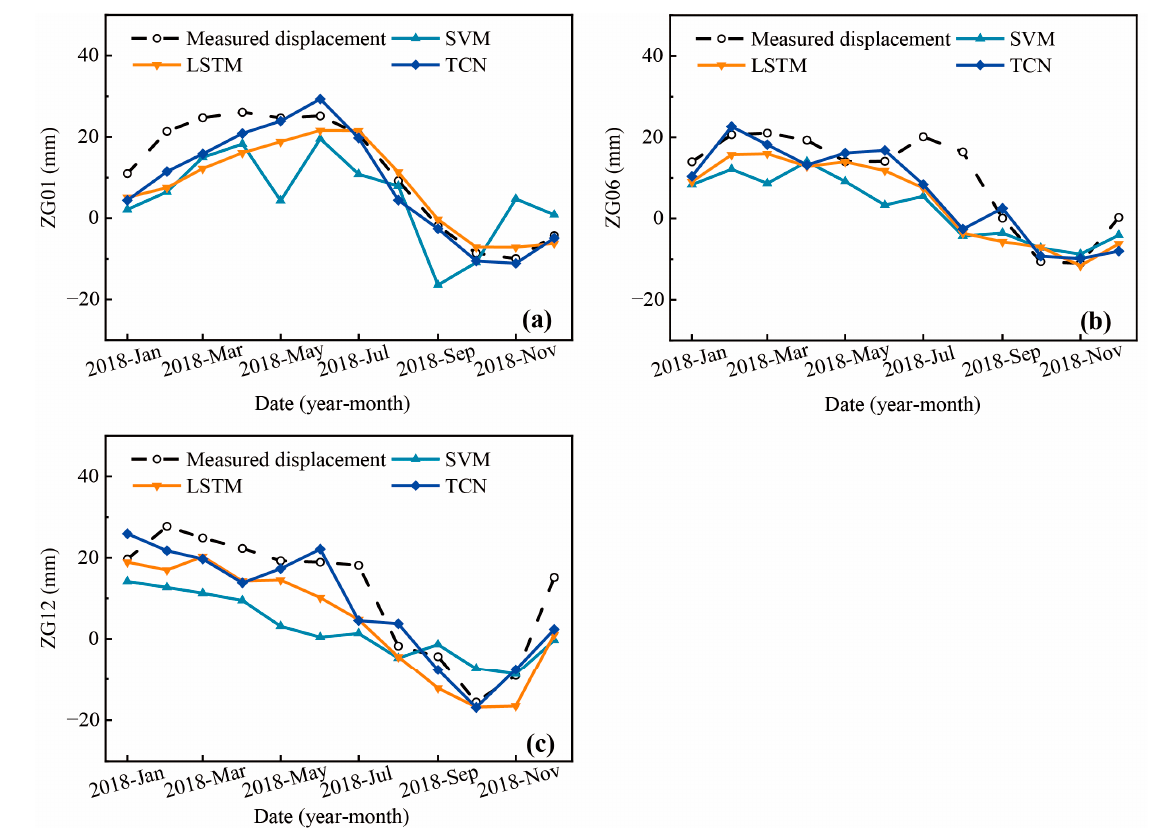
Figure 12. A comparison of monitored and predicted periodic displacements using three prediction models for different sites: ( a ) ZG01, ( b ) ZG06, and ( c ) ZG12.